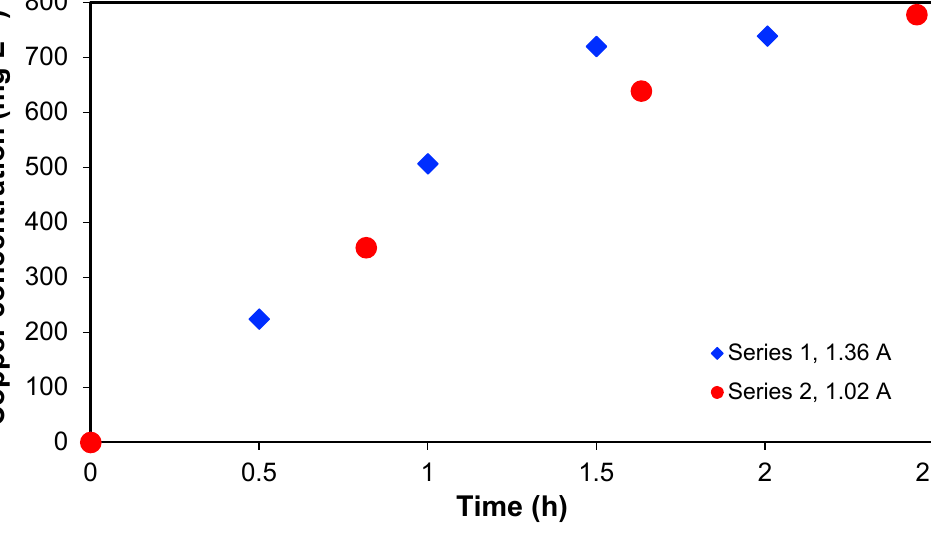
Figure 4. Copper concentration in Section 2 for series 1 and 2 as a function of time.